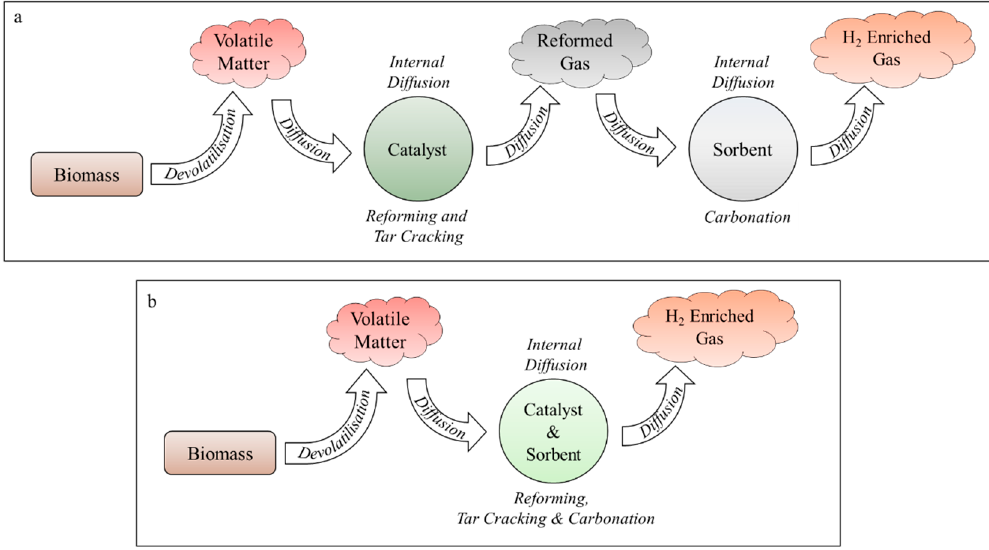
Figure 1. Representation of the overall Sorption Enhanced Steam Reforming (SESR) mechanism and associated mass transfer, diffusional resistances present in during SESR of biomass for separated ( a ) and single particle ( b ) systems.